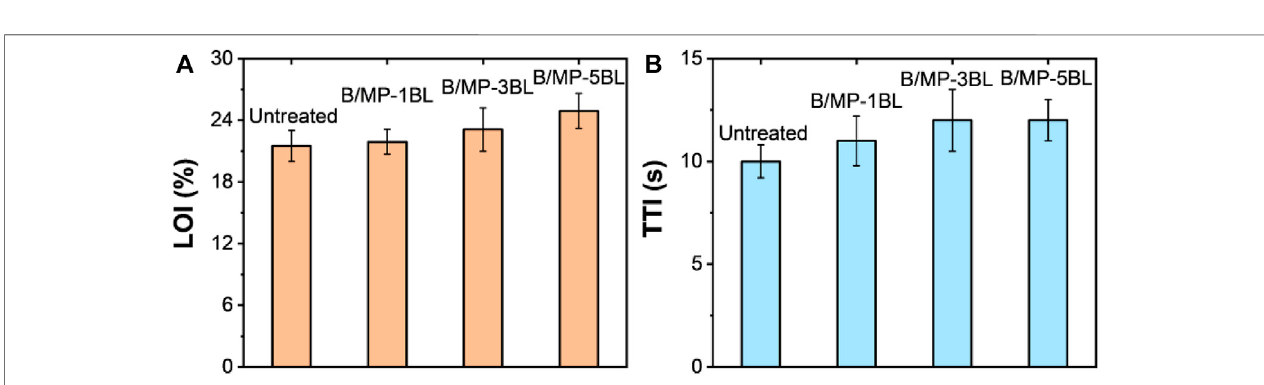
FIGURE 5 | LOI (A) and TTI (B) of untreated and treated bamboo with different times of the cycle.